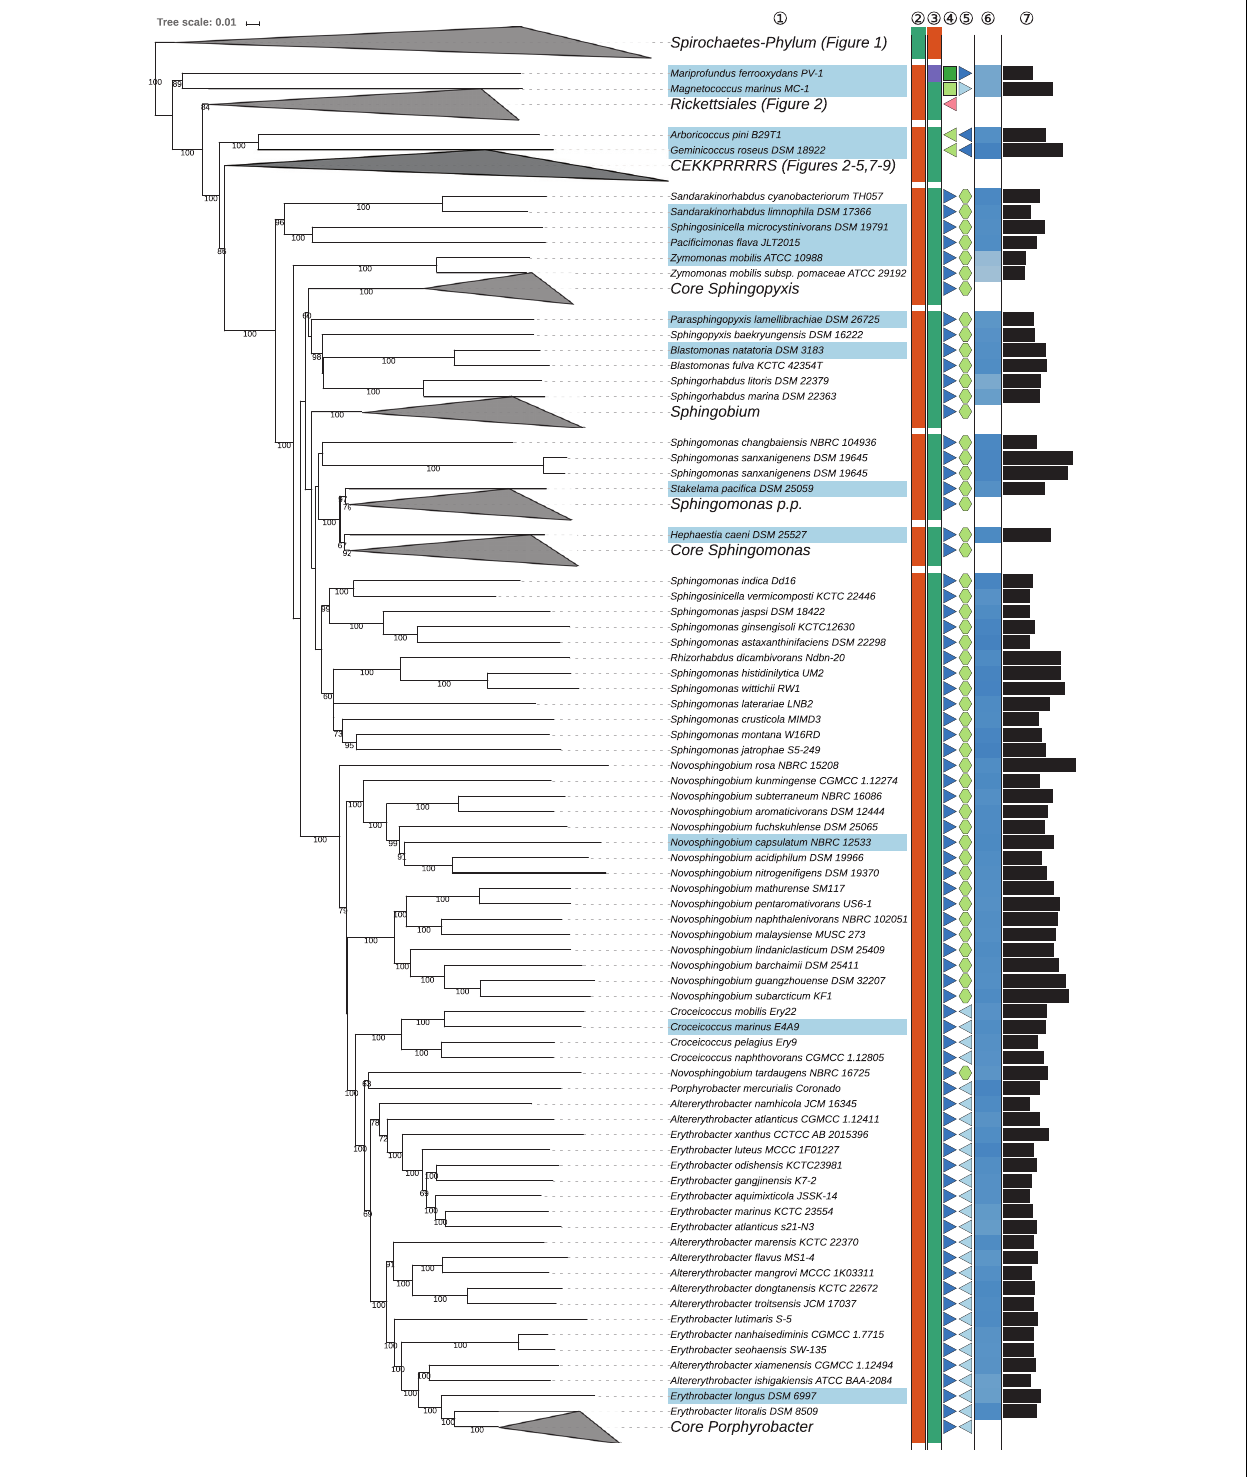
FIGURE 6 | Fifth part of the GBDP tree shown in Figure 1 , focussing on Sphingomonadales . The clade labeled CEKKPRRRRS comprises the orders Caulobacterales, Emcibacterales, Kiloniellales, Kordiimonadales, Parvularculales, Rhizobiales ( Hyphomicrobiales ) , Rhodobacterales, Rhodospirillales, Rhodothalassiales, and Sneathiellales , details for which are shown in other figures. Tip labels with light-blue background indicate type species of genera, colors and symbols to the right of the tips indicate, from left to right, phylum, class, order, and family; for details and abbreviations see Figure 1 . The blue color gradient indicates the G+C content as calculated from the genome sequences, followed by black bars indicating the (approximate) genome size in base pairs. Sphingomonas sanxanigenens DSM 19645 is represented by two genome sequences (SAMN02641489, above; SAMN02745820, below).